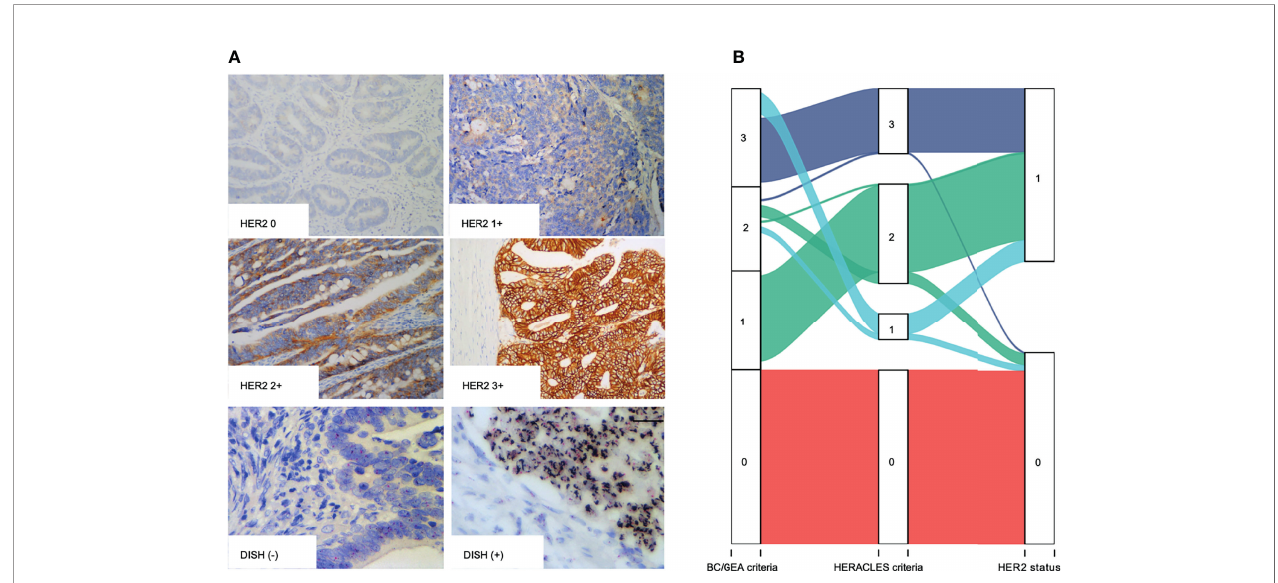
FIGURE 1 | IHC and DSISH staining of HER2. (A) Representative IHC intensity (0, 1+, 2+, and 3+) of tumor cells (original magni fi cation, ×200) and representative negative (DSISH − ) and positive (DSISH+) ampli fi cation of HER2 gene (original magni fi cation, ×400). (B) Alluvial diagram shows the distribution of each case in different diagnostic criteria. IHC, immunohistochemistry; DSISH, dual-color silver-enhanced in situ hybridization; HER2, human epidermal growth factor receptor